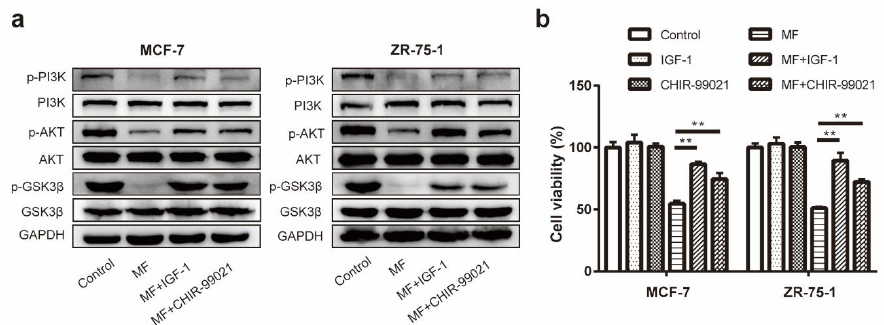
Figure 6. The activation function of LF-MF on GSK-3 β was partially attenuated by IGF-1 and CHIR-99021. ( a ) Western blotting was performed to confirm that activating PI3K / AKT (IGF-1) or inactivating GSK-3 β (CHIR-99021) suppressed MF-induced p-PI3K and p-AKT and p-GSK-3 β decrease. ( b ) MTT assay showing that GSK-3 β inactivation reversed the reduced viability caused by MF exposure. n = 3; ** p < 0.01.